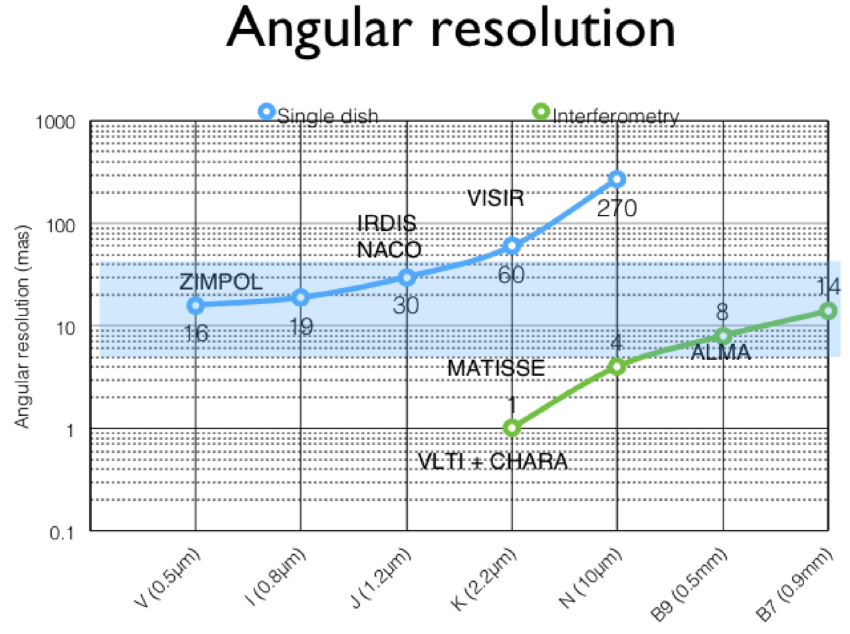
Figure 1. Angular resolution (in miliarcsec) as a function of wavelength for the instruments of the Very Large Telescope (VLT), the Very Large Telescope Interferometer (VLTI), CHARA and